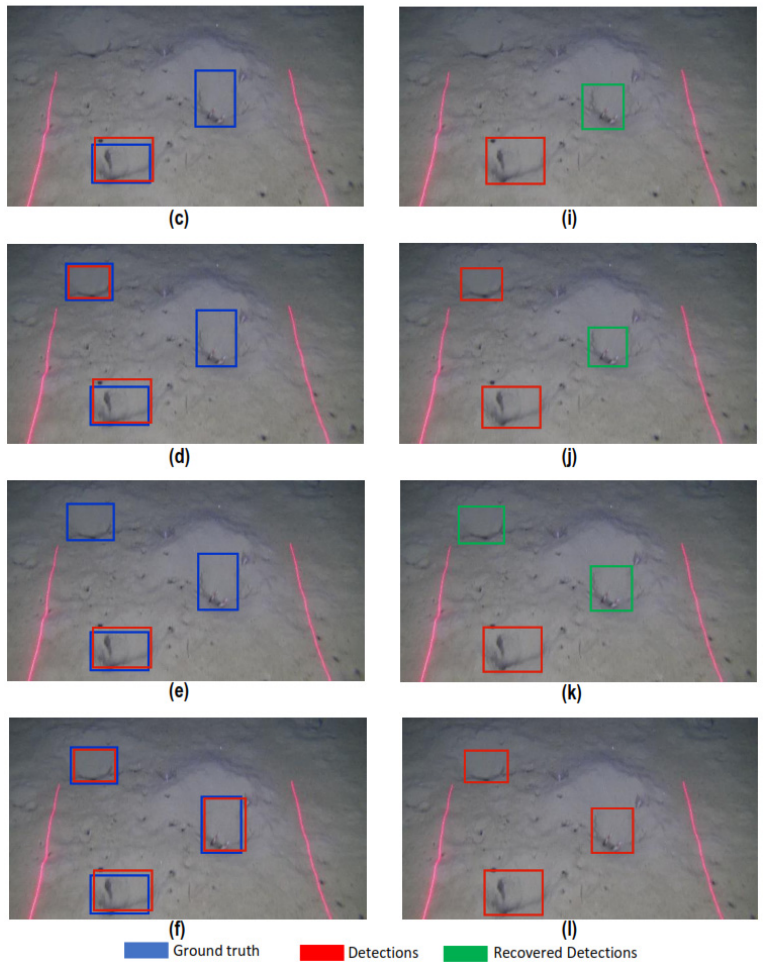
Figure 11. Identification of true positive missed detections. Panels ( a–f ) are the original detections from the Inception model, and ( g – l ) are the identification of missed detections in the consecutive frames.